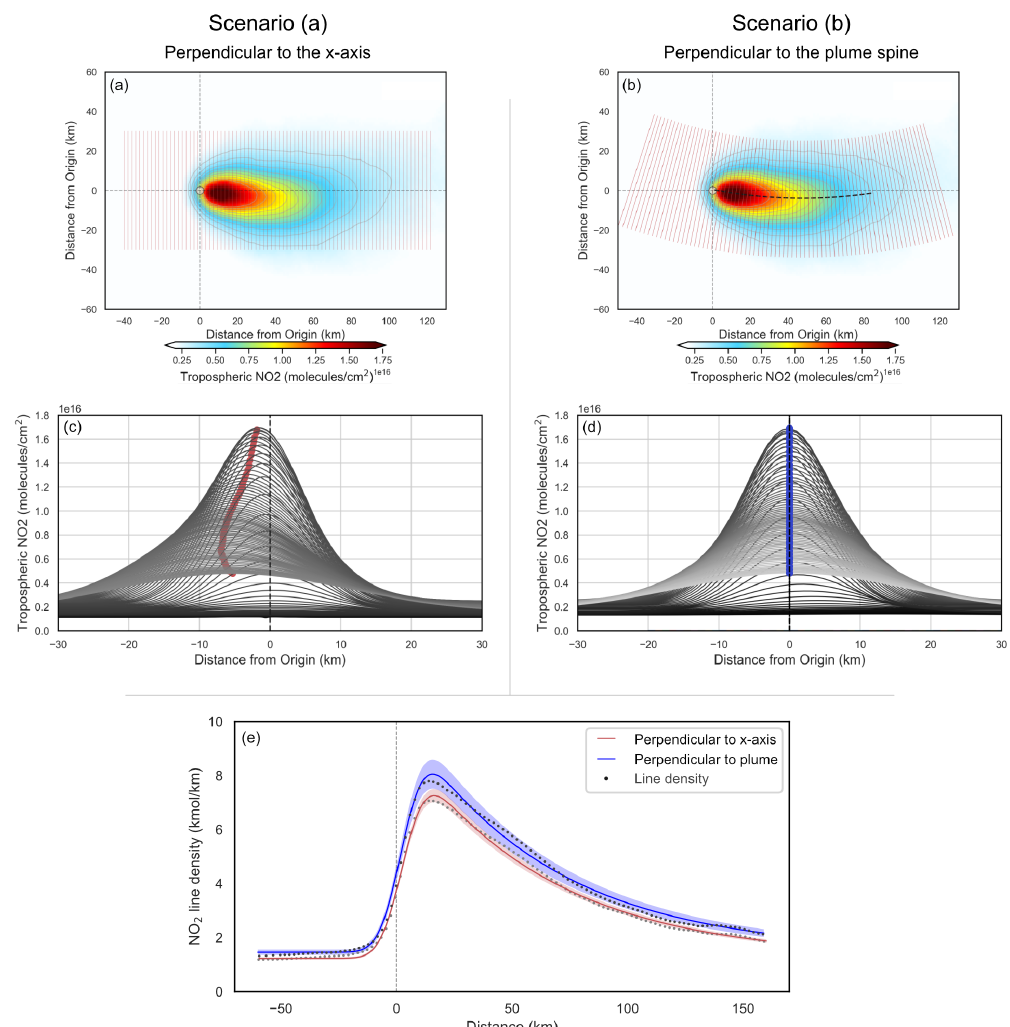
Figure 11. Demonstration of the impact that the Coriolis effect has on the resulting emission estimate. Panels (a) and (c) show the results using cross sections perpendicular to the x axis, whereas panels (b) and (d) show cross sections perpendicular to the plume of the spine. Panel (e) shows the EMG fit for each scenario, with the shaded region showing the quality of each